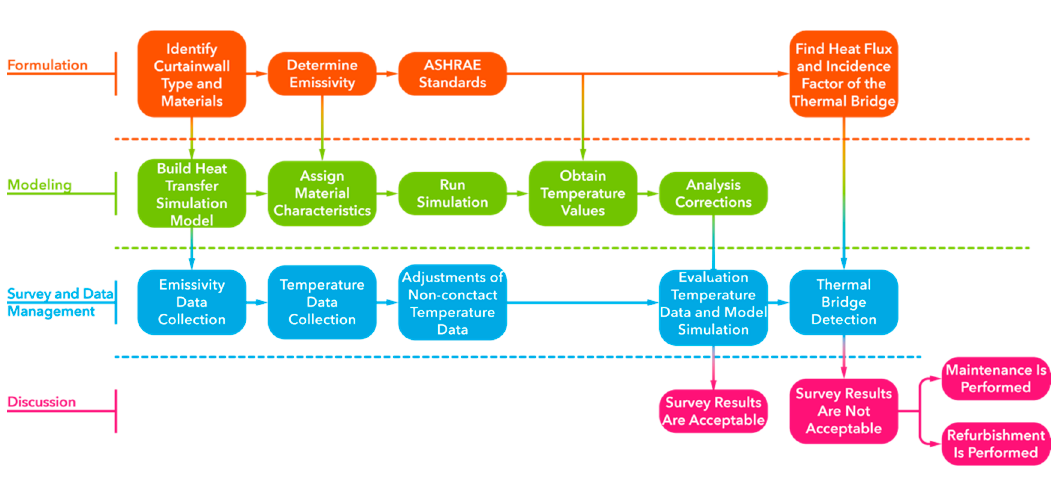
Figure 2. Framework for the detection, diagnosis, and evaluation of thermal bridges.